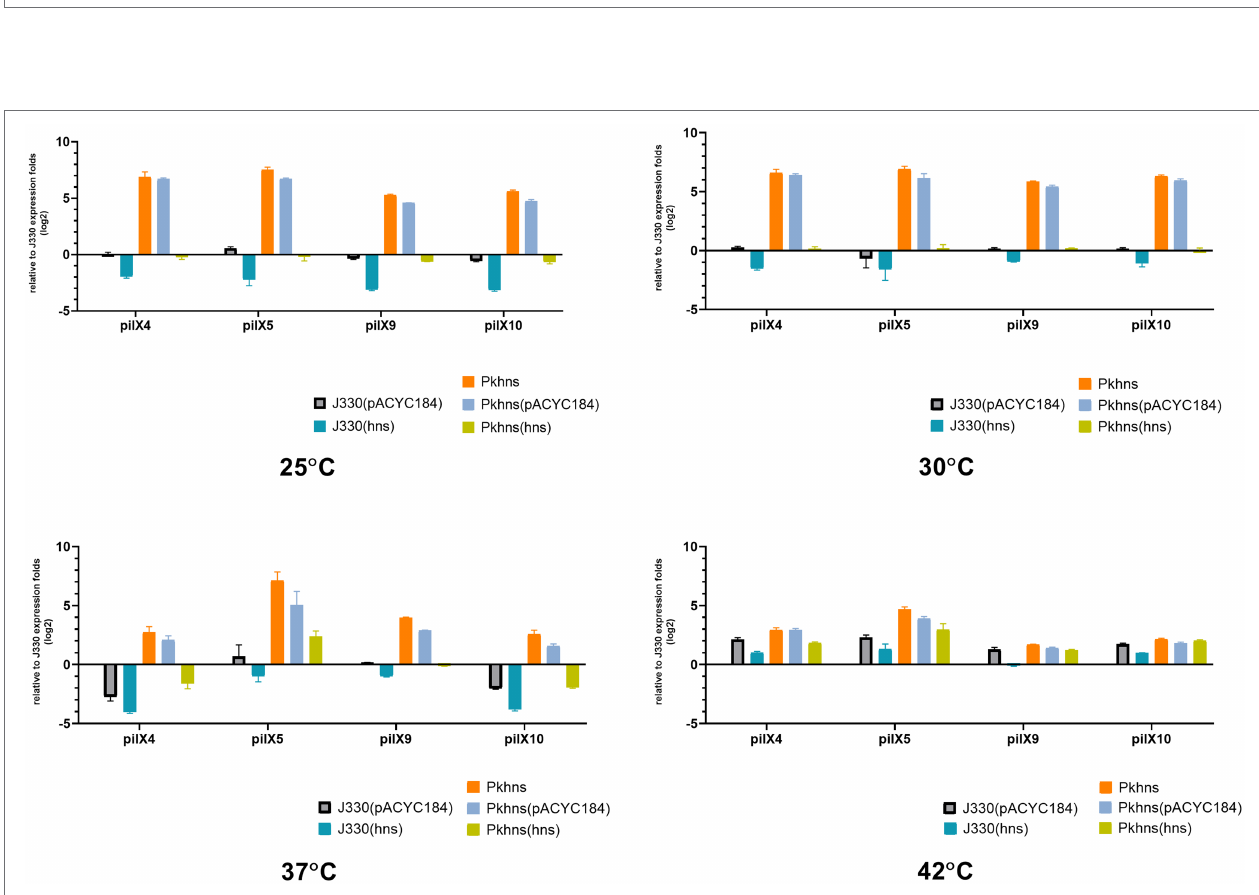
FIGURE 4 | (A) Comparison of the frequency of conjugative transfer between the phns gene deletion plasmid and the original plasmid at different temperatures. At different temperatures, the joint frequency of pGZIncX3 Δ hns and pGZIncX3. (B) Comparison of conjugation frequency of pGZIncX3 at three different temperatures and 37 degrees when phns gene was overexpressed.